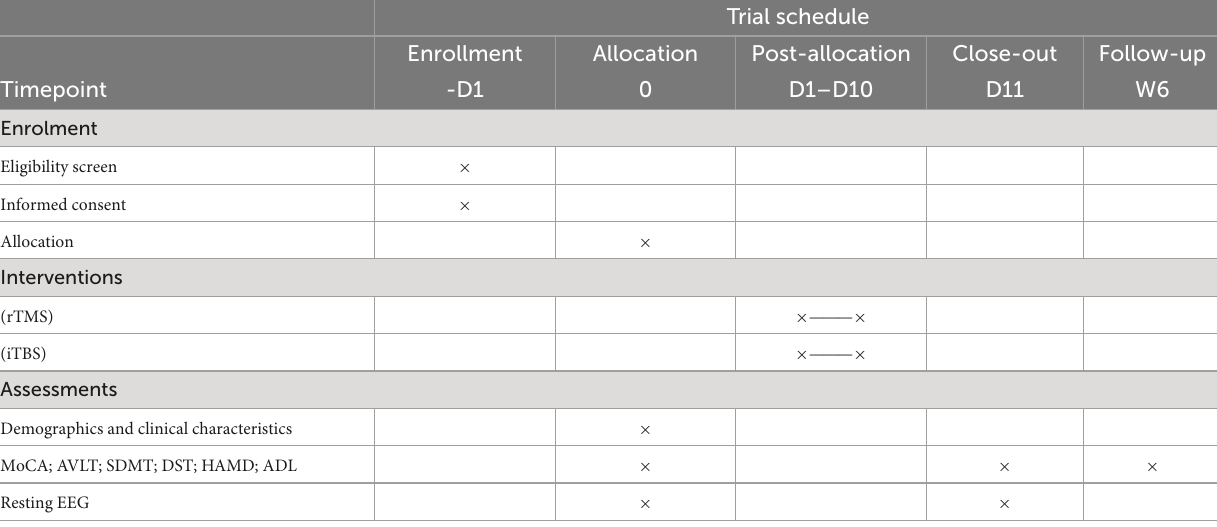
TABLE 1 Trial schedule.